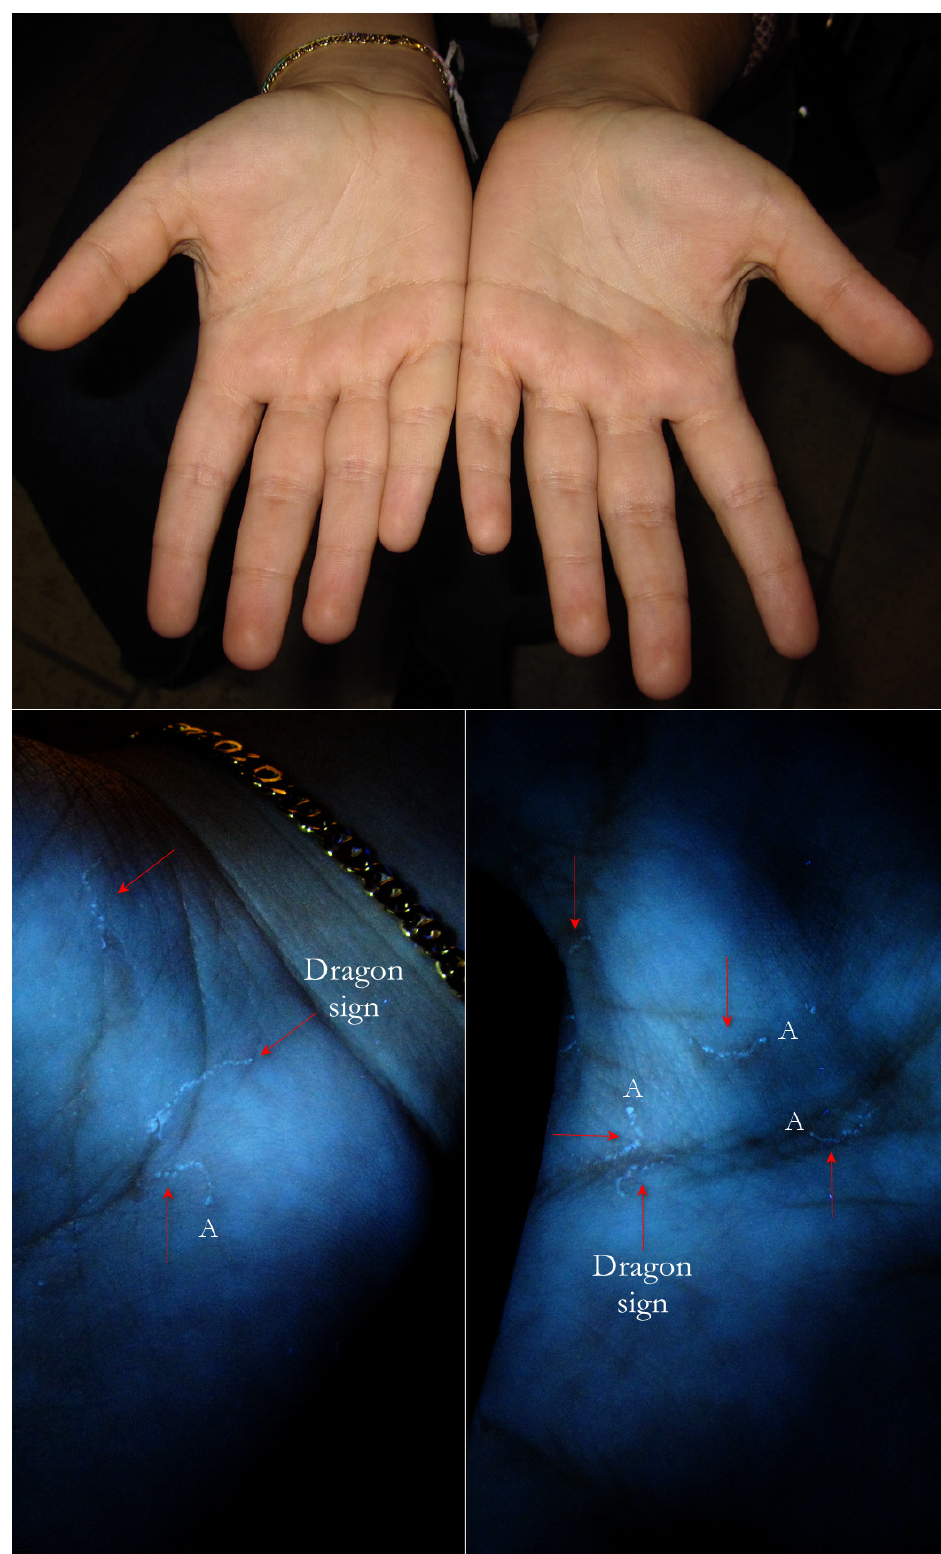
Figure 13. Flash light vs. UVA. Two palms under flash light did not show any problems. However, under UVA, some Mite-Gallery Units (red arrows) were immediately visible as segmented lines (dragon sign). At one extreme, some of them exhibited a little white dot (A) where the Sarcoptes body was located. The lines drawn were finely segmented because the gallery roof was